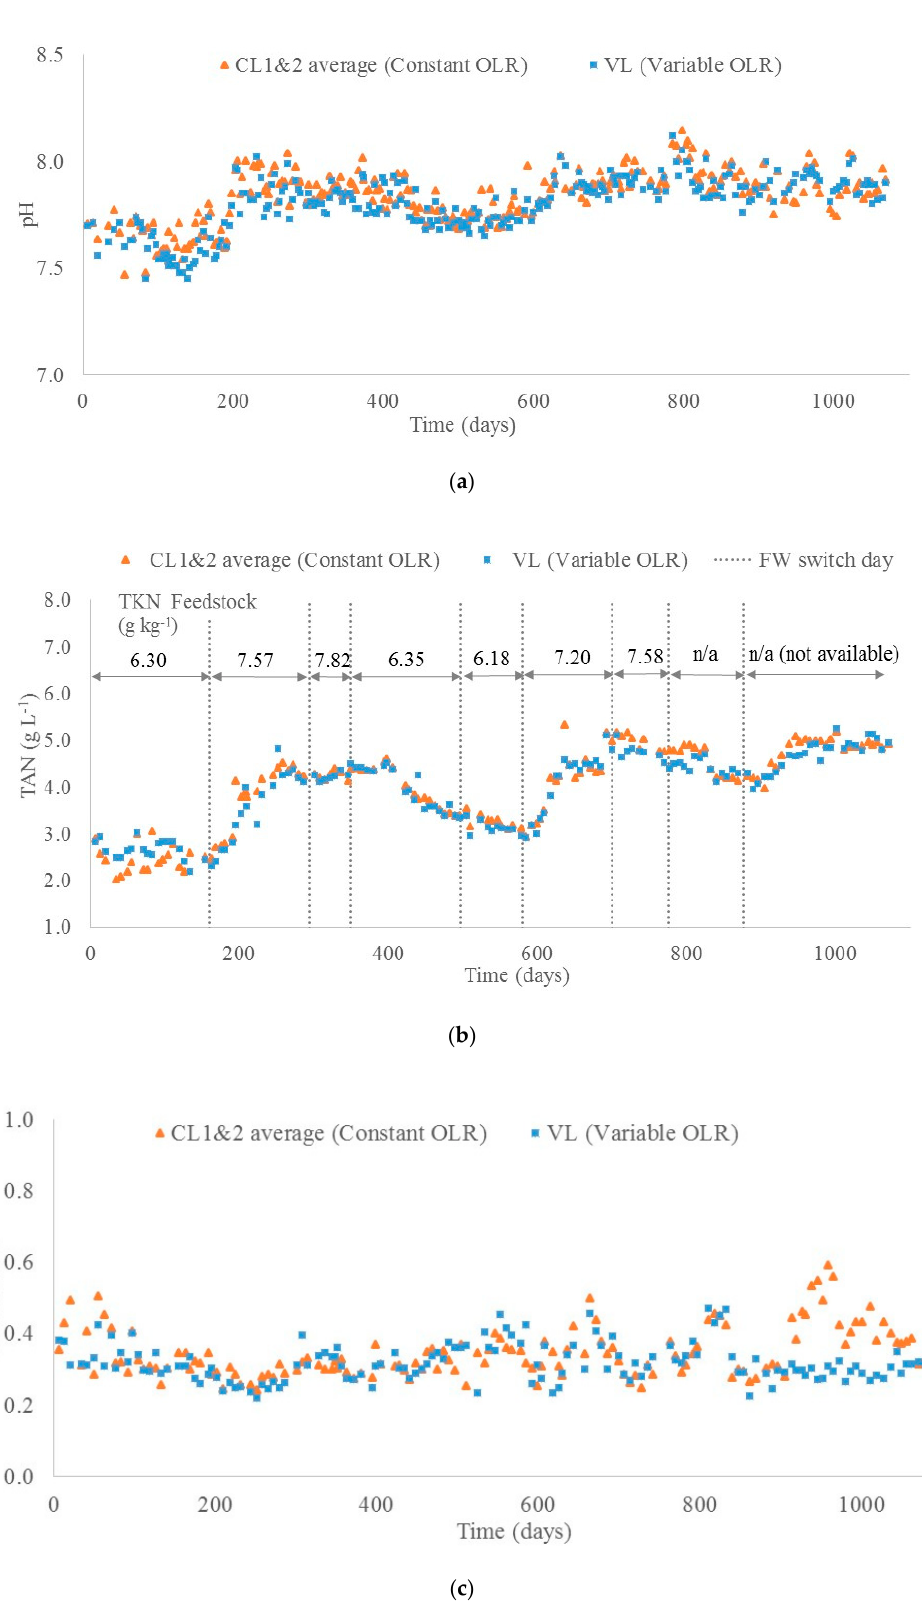
Figure 3. Operational parameters of digester VL with variable OLR and the control with constant loading (CL1&2, average values): ( a ) pH of digester content (measured in digestate leaving the digester); ( b ) Ammonia of digester content (additionally, TKN of feedstock is provided); ( c ) Alkalinity of digester